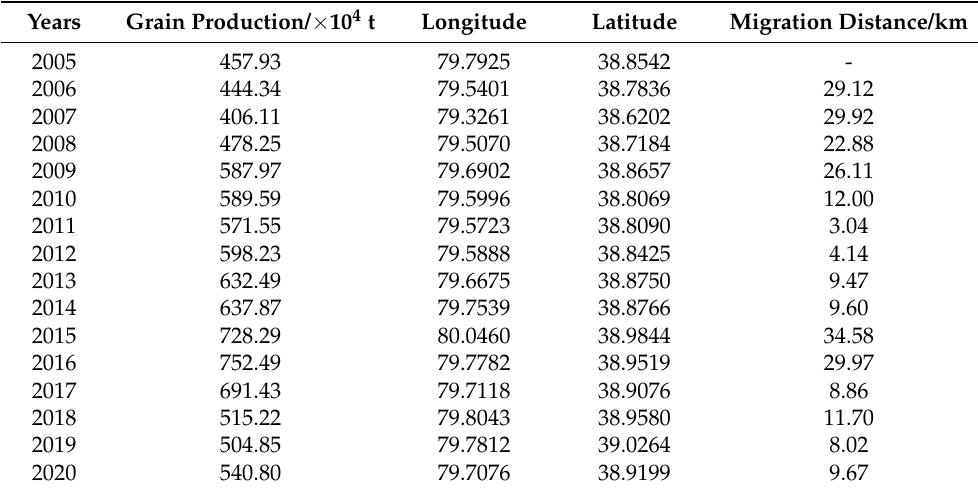
Table 1. Grain production, center of gravity coordinates and migration distance in the Tarim River